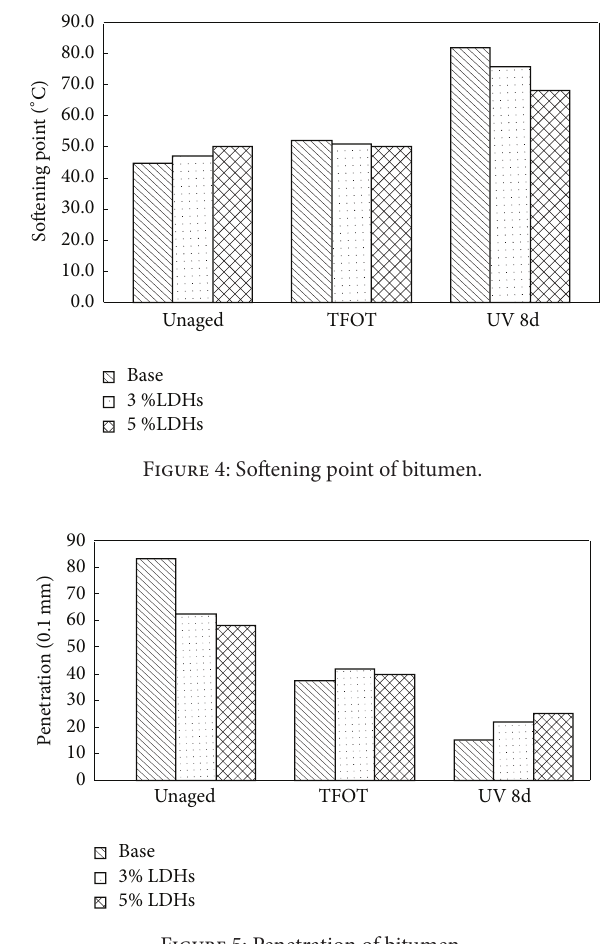
Figure 5: Penetration of